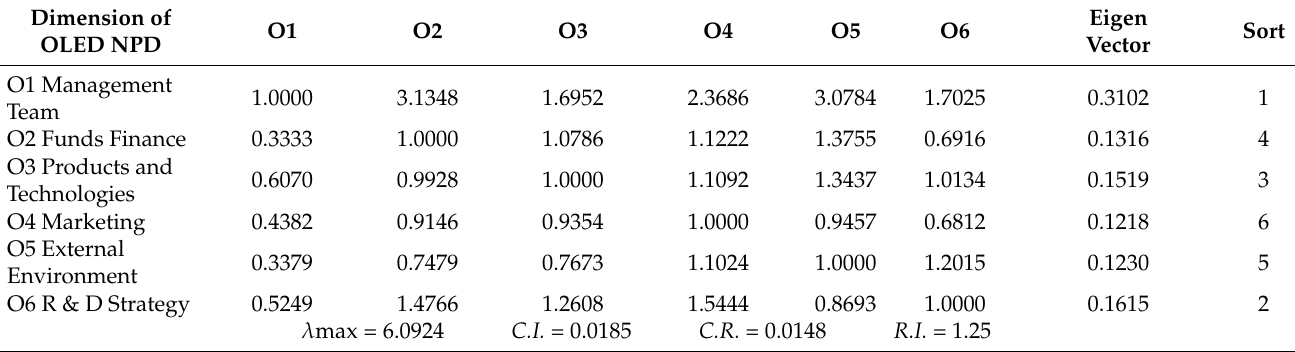
Table 9. The defuzzification of fuzzy pairwise comparison